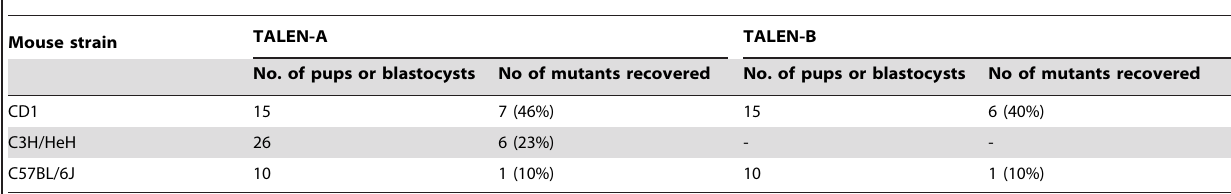
Table 1. Microinjection